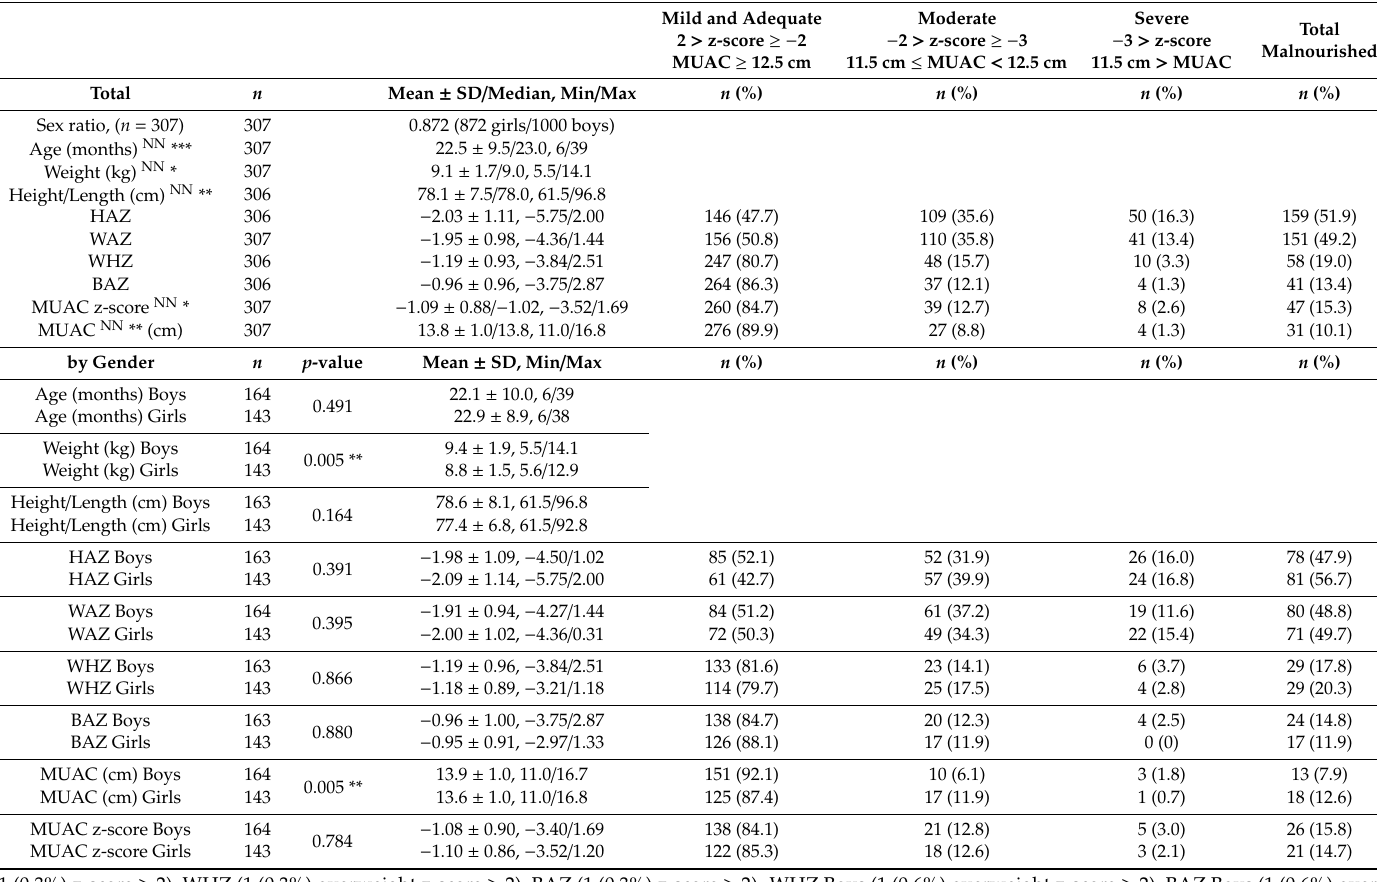
Table 1. Nutritional status of Santal Adivasi children (total) and by